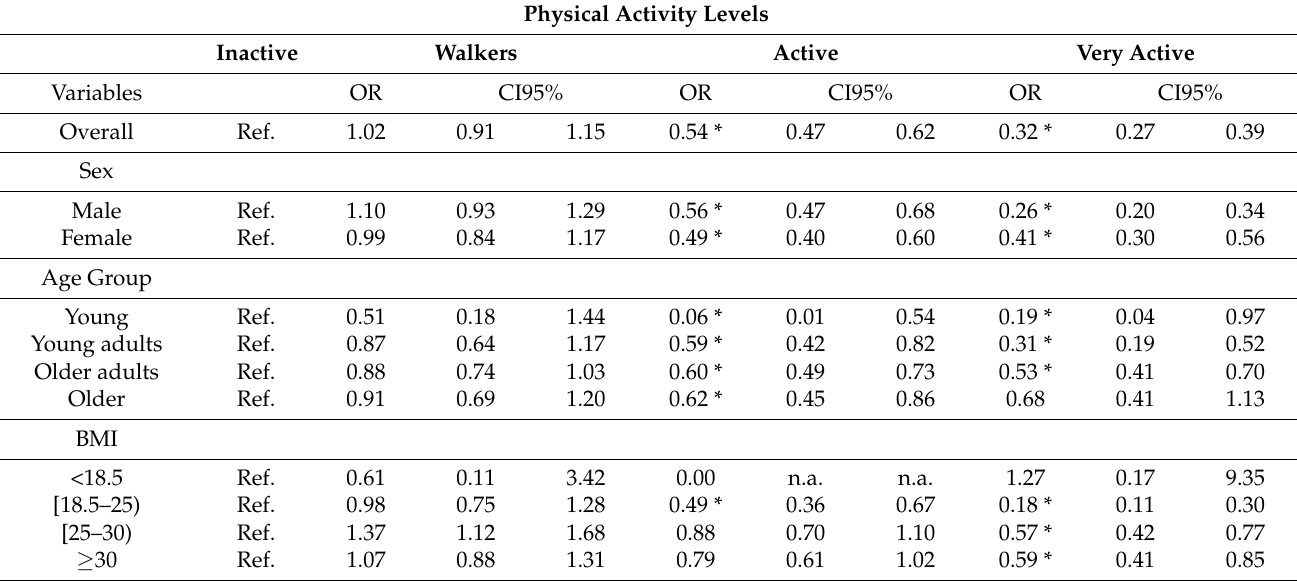
Table 7. Risks of use of antihypertensive drugs, according to level of physical